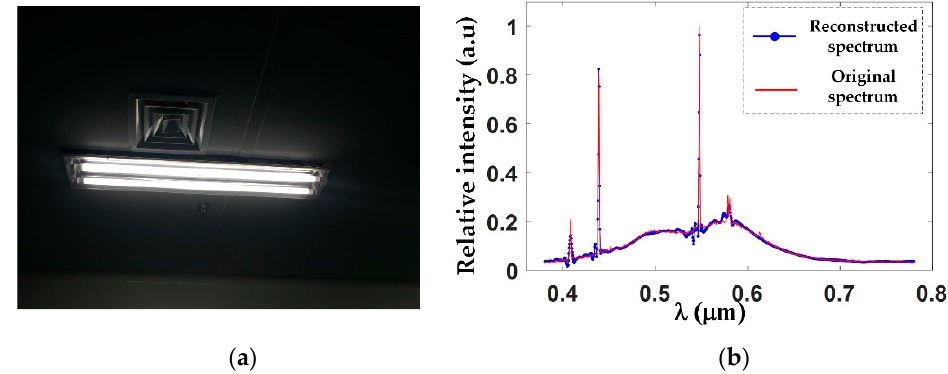
Figure 9. Fluorescent lamp spectrum measurement experiment: ( a ) Laboratory lighting fluorescent lamp source; ( b ) Compressed sensing spectrum measurement result.